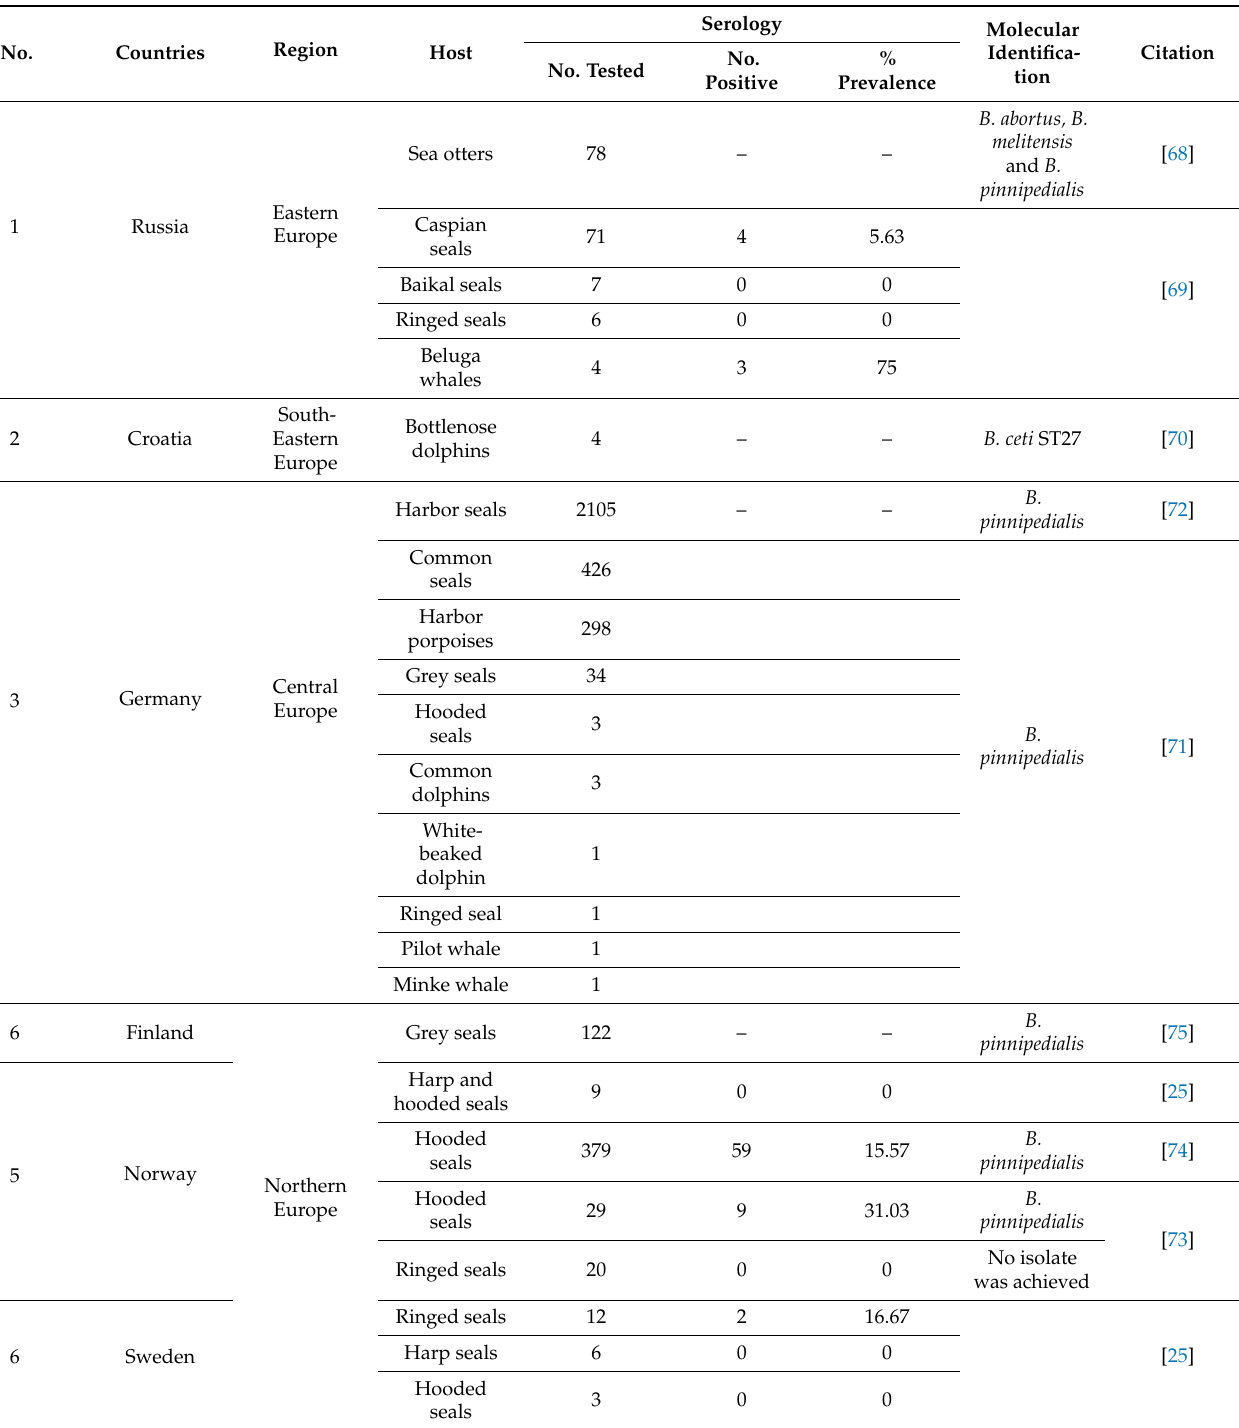
Table 2. Brucellosis in European marine